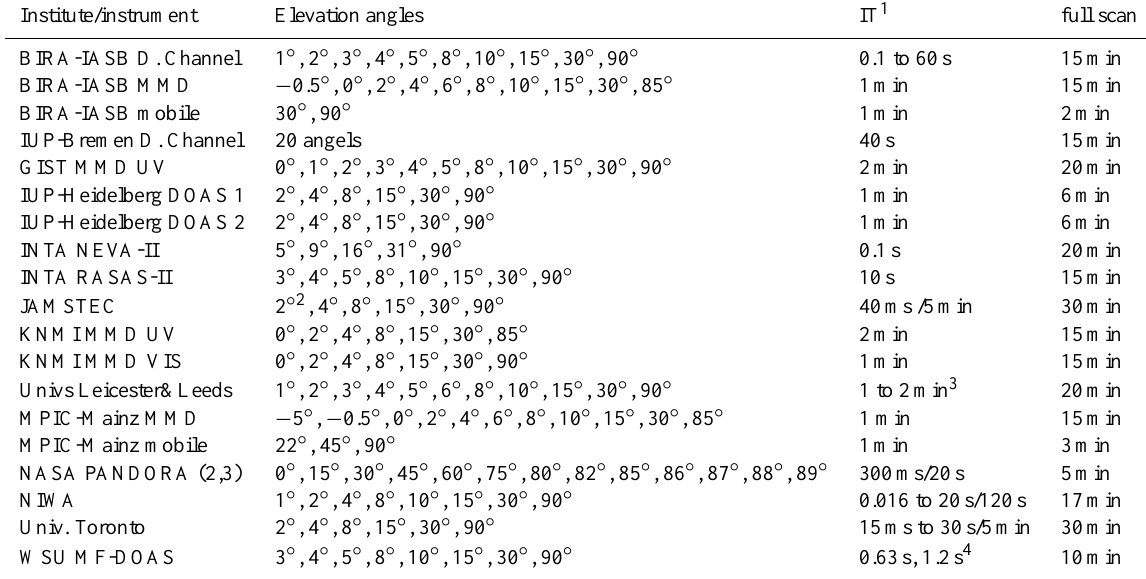
Table A1. Elevation angles, integration times and full scan durations of the MAX-DOAS systems during CINDI. Institute/instrument Elevation angles IT